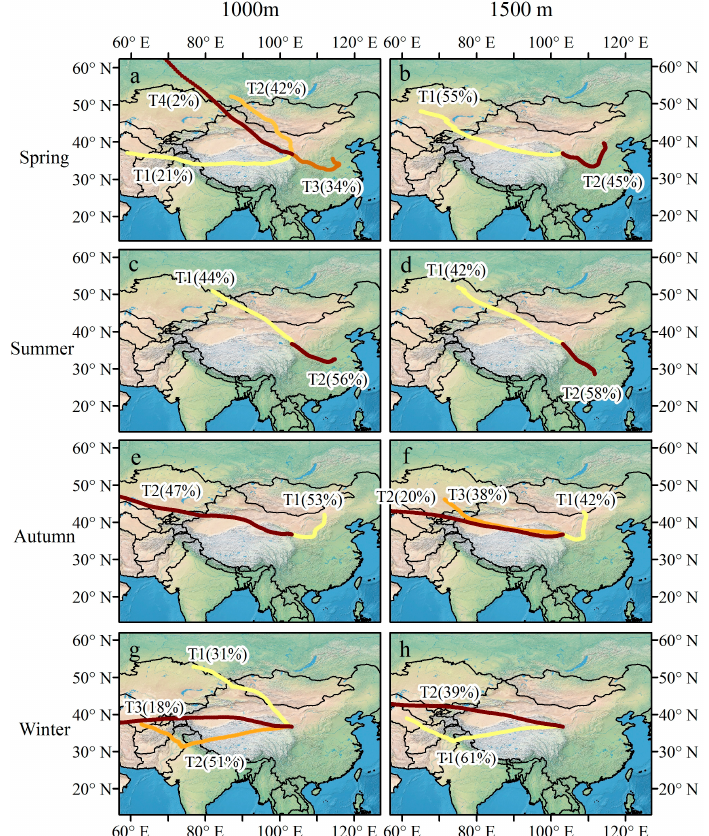
Figure 4. Clustered backward trajectories during different seasons to the Lanzhou city. The target altitudes are set as 1000 ( a , c , e , g ) and 1500 m ( b , d , f , h ), respectively. The percentages in brackets denote the proportions in trajectory amount for each cluster in total amount.